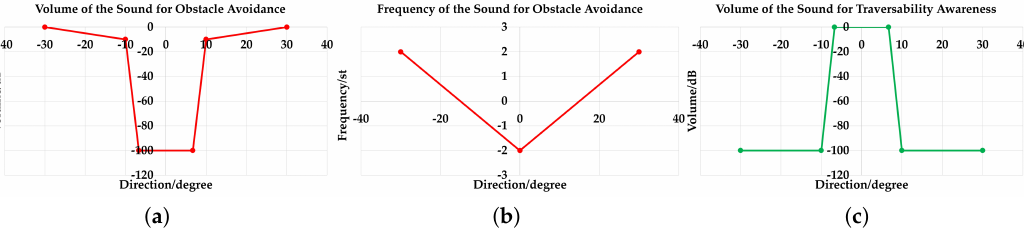
Figure 12. Detailed parameters of the sound mapping: ( a ) volume of the sound for obstacle avoidance; ( b ) frequency of the sound for obstacle avoidance; ( c ) volume of the sound for traversability